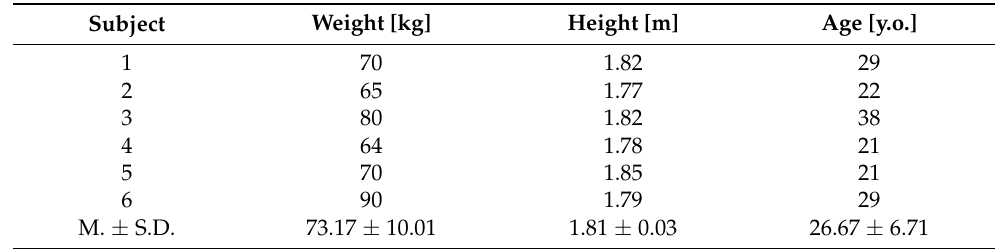
Table 2. Table of characteristics of the subjects who participated in the study. (M.: Mean, S.D.: Standard